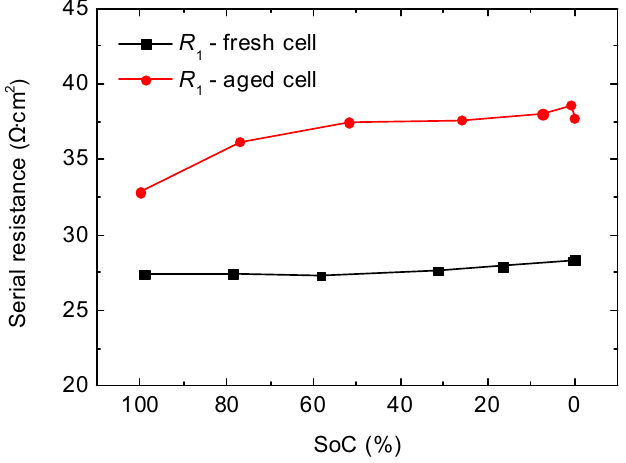
Figure 11. Evolution with SoC of the serial resistance ( R 1 ) of an LCO-NMC/graphite full-cell when evaluated at 25 °C. The results are represented for a fresh cell and an aged cell.